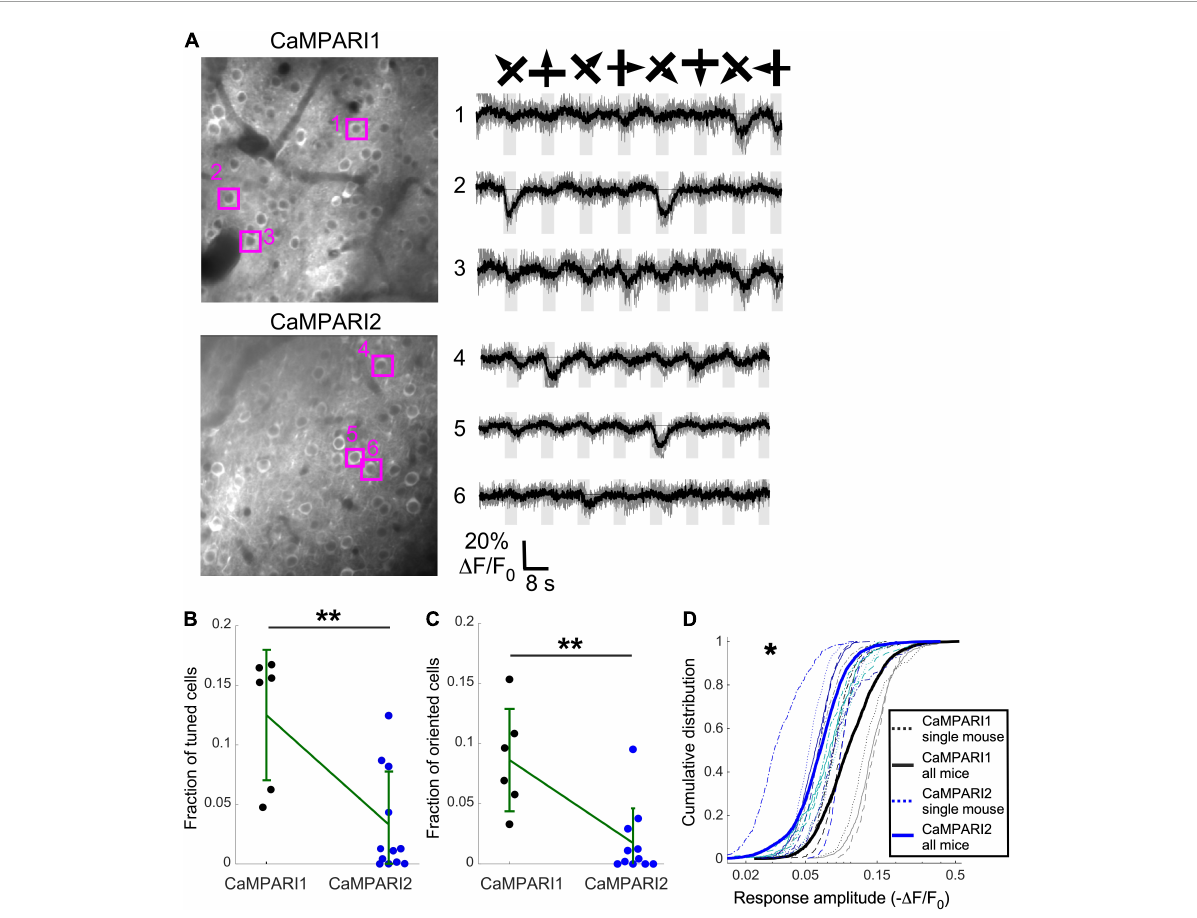
FIGURE4 CaMPARI1 outperforms CaMPARI2 for recording dynamic activity patterns in the mouse V1. (A) Example images (left) and example traces (right) of CaMPARI1- (top) and CaMPARI2-expressing (bottom) neurons in the mouse V1. The example traces were selected from tuned and oriented cells, and the respective cell locations are highlighted on the image. (B,C) The fractions of tuned (B) and oriented (C) neurons in V1 were higher for CaMPARI1-expressing than CaMAPRI2-expressing mice [ n = 4 CaMPARI1 mice, with two mice recorded twice ( n = 502, 692, 208, 498, 433, and 757 neurons/recording); n = 8 CaMPARI2 mice, with three mice recorded twice (122–942 cells/recording with median number of 273)]. The increase was significant for the fraction of tuned cells (0.125 ± 0.055 vs. 0.033 ± 0.045 for mean ± standard deviation of CaMPARI1 vs. CaMPARI2, respectively; p = 0.005, Wilcoxon Ranksum Test) as wells as the fraction of oriented cells (0.086 ± 0.043 vs. 0.018 ± 0.029; p = 0.002, Wilcoxon Ranksum Test). Error bars show the standard deviation for each sensor and the mean values are connected with a green line. (D) The cumulative distribution of the peak response amplitude for a visual stimulus of all recorded V1 neurons from all mice shows a significant decrease in CaMPARI1’s response amplitudes [median value across all median cumulative distributions of –0.105 ± 0.035 for CaMPARI1 vs. –0.072 ± 0.016 for CAMPARI2; median ± standard deviation; p = 0.02; Wilcoxon Ranksum Test between the median values of all recorded neurons on the same recording session; thin dashed lines show data from single recordings and solid lines show the piled distribution from all recorded mice with the same sensor; same mice as in (B,C)] . * p < 0.05, ** p <